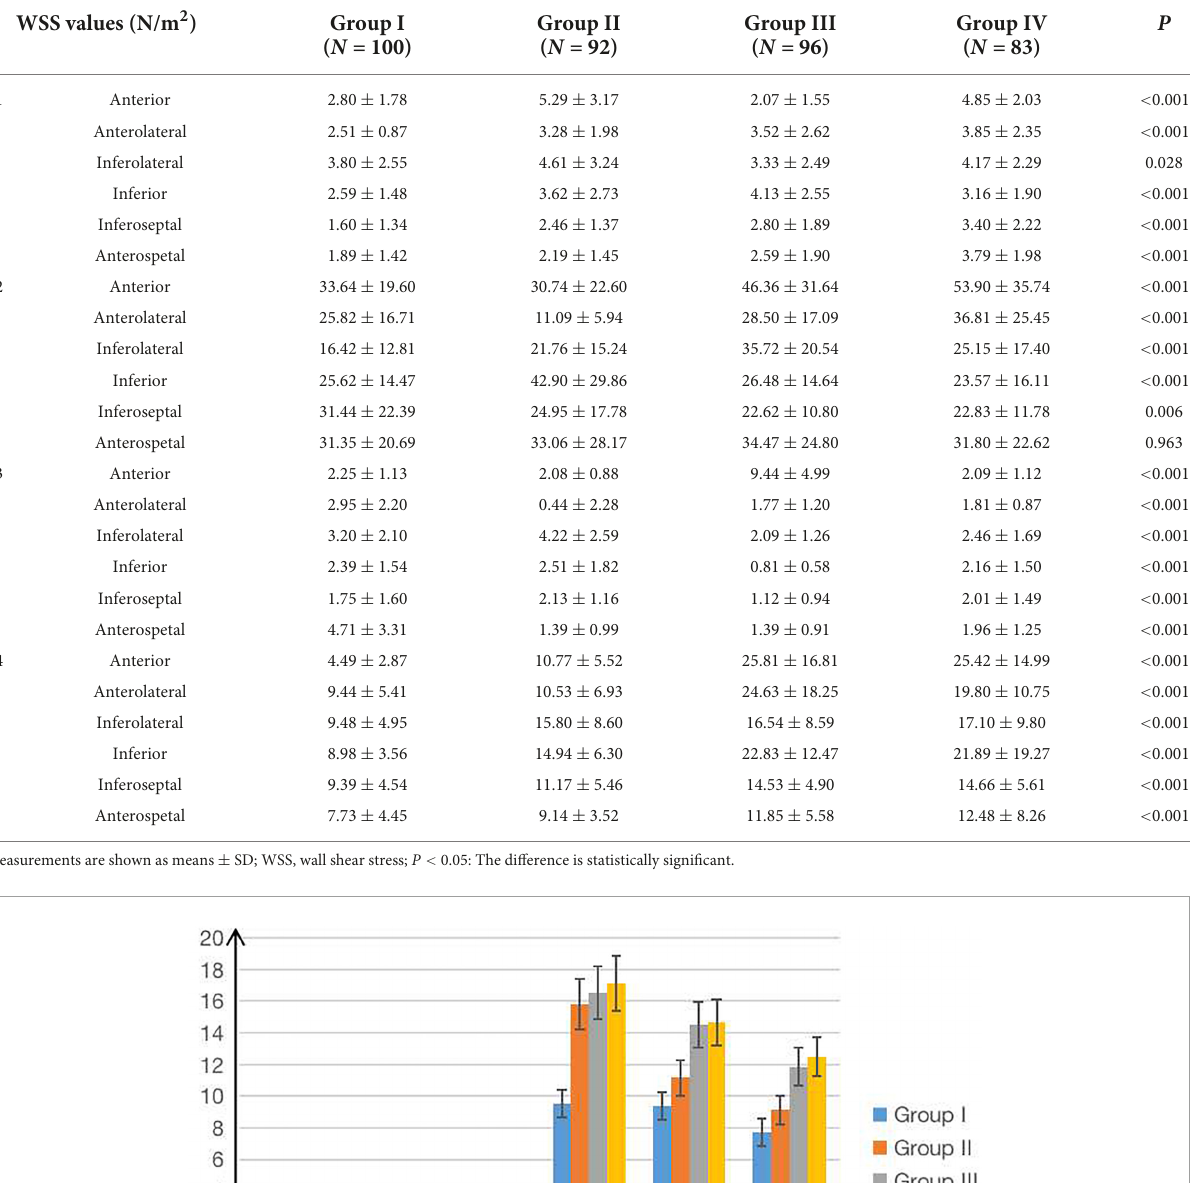
FIGURE4 The increasing trend of the LV WSS in four age groups.